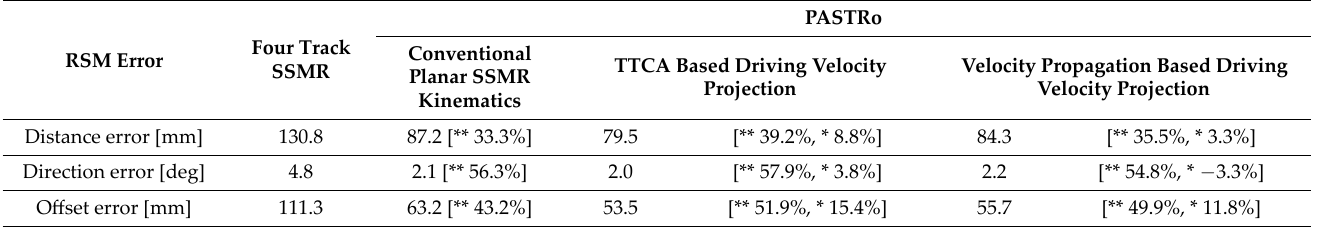
Table 6. Maneuverability performance